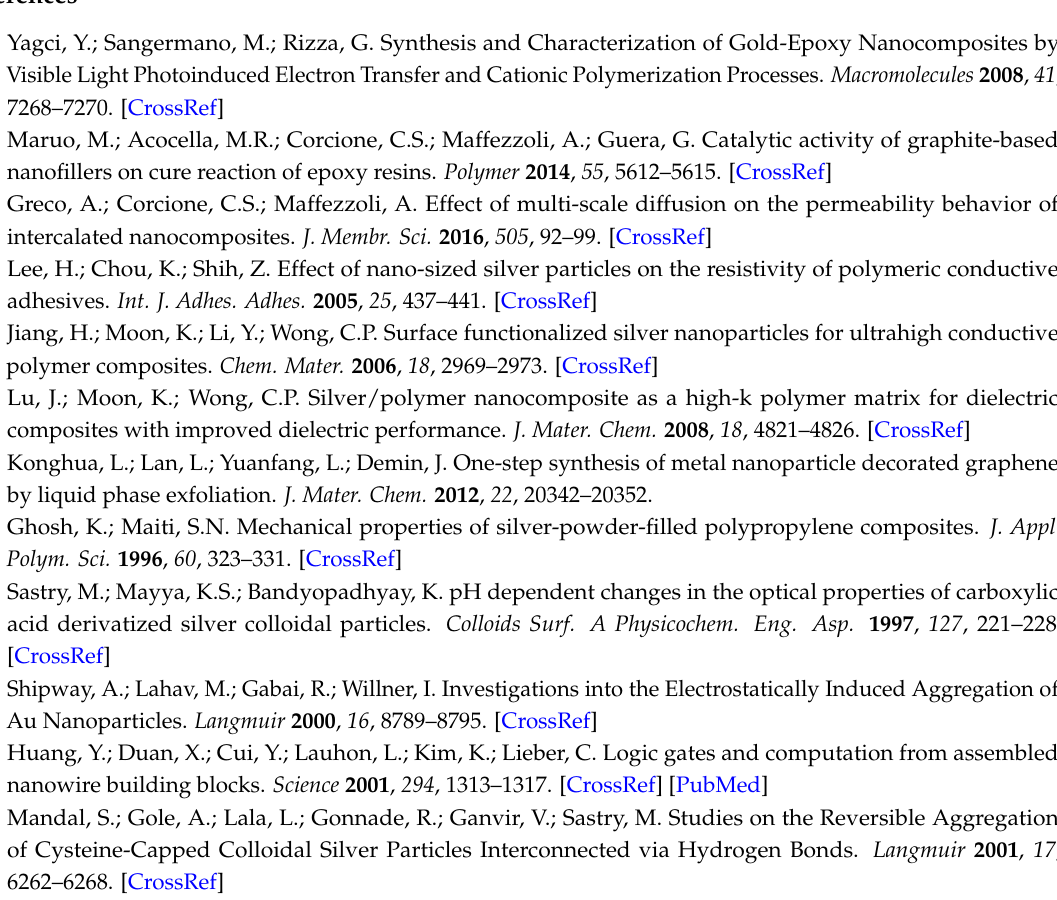
Figure S1: DSC thermograms obtained by scanning at heating rate of 10 ˝ C/min in N 2 gas environment for the epoxy resins containing anhydride type curing agent: ( a ) without silver-imidazole complex; ( b ) with 10 wt % of the silver-imidazole complex. Exothermic heat of cure in ( b ) was 321.3 J/g, Figure S2: Fittings to the percolation model Equation (1) for surface electrical resistivity of the samples shown in Figure 4: ( a ) sample cured with imidazole in direction of the highest resistivity; ( b ) sample cured with imidazole in the direction perpendicular to that of ( a ); ( c ) sample cured with silver-imidazole complex in direction of the highest resistivity; ( d ) sample cured with silver-imidazole complex in the direction perpendicular to that of ( c